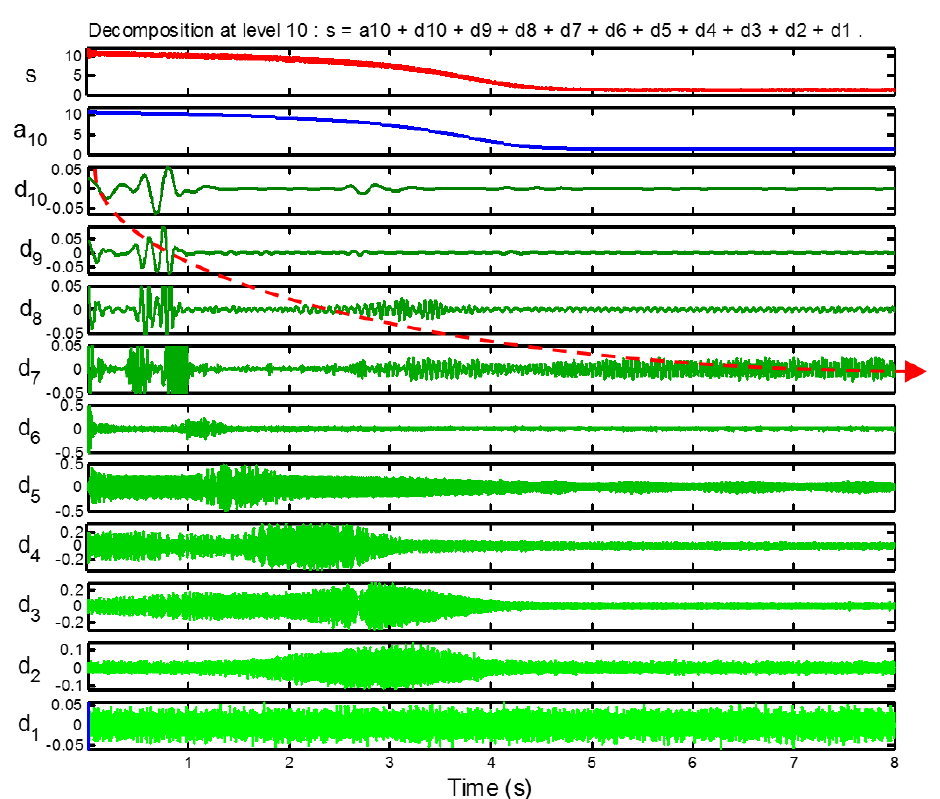
Figure 17. Wavelet decomposition of the start-up current; the components related to mixed eccentricity are included in the detail signals d 7 to d